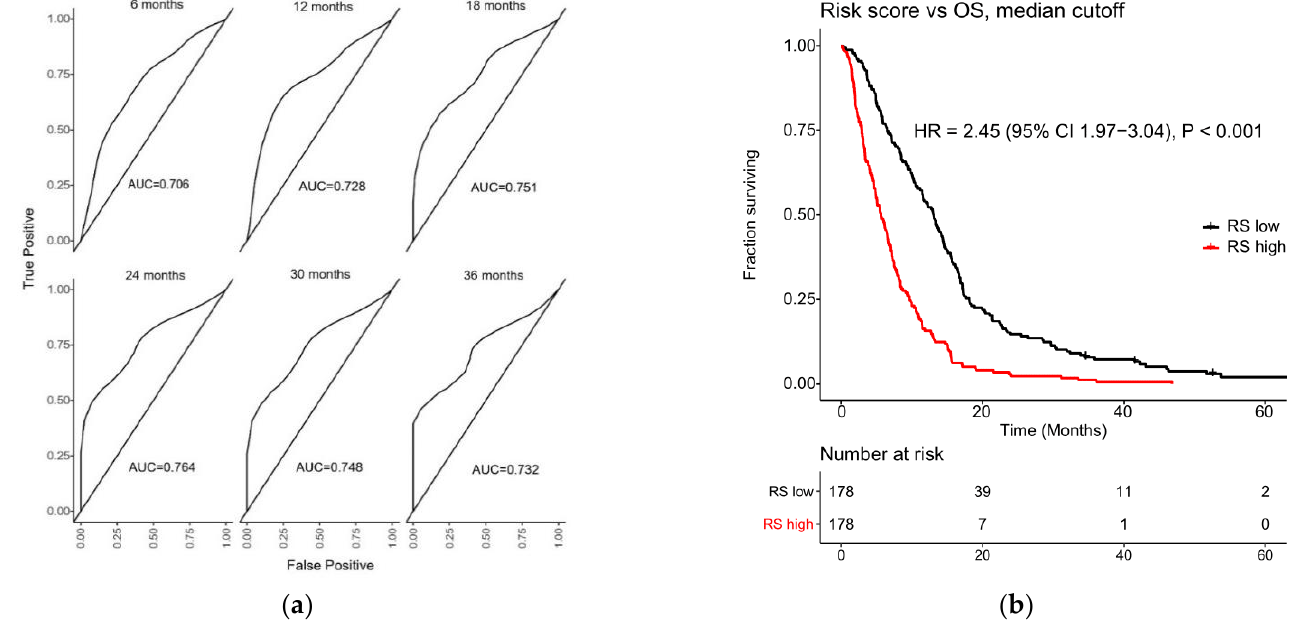
Figure 2. Index II: ( a ) Time-dependent ROC curves for Index II (whole cohort). Plots shown for predicting OS at 6, 12, 18, 24, 30, and 36 months, respectively. AUC values shown for each plot. Y-axes show the true positives and x-axes show the false positives; ( b ) Kaplan–Meier plot showing the risk score developed using Index II for each patient, plotted against survival. The division of patients is < or > median risk score.